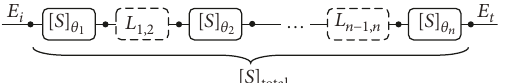
× 0 43 λ 0 0 ) of the two proposed LP converter devices with (a)